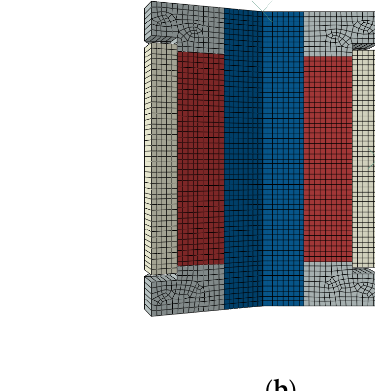
Figure 2. The PS-LED: ( a ) longitudinal section and ( b ) finite element model.